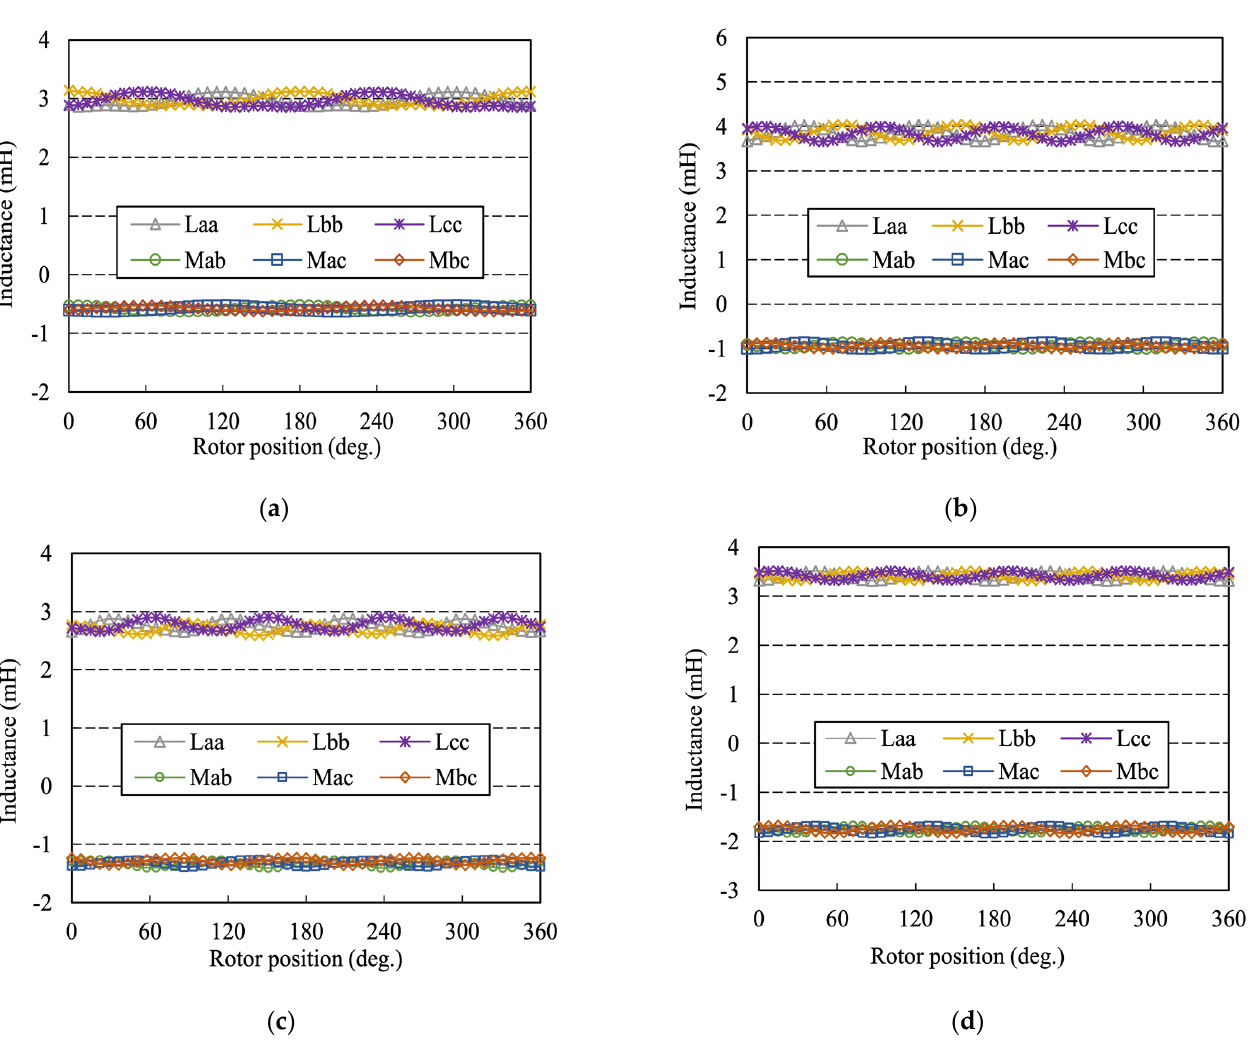
Figure 7. Self-inductance and mutual inductance of the four candidates. ( a ) 12/10 U-core; ( b ) 12/11 U-core; ( c ) 6/10 E-core; ( d ) 6/11 E-core.